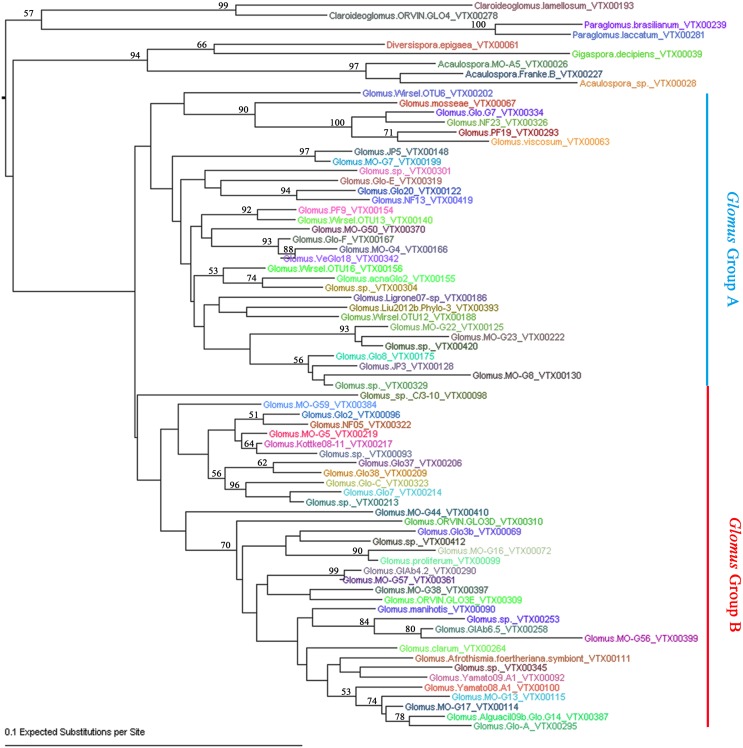
Neighbor-joining phylogenetic tree of AMF species detected in citrus roots. The F84+Gamma nucleotide substitution model was used and bootstrap values of >50 are shown.